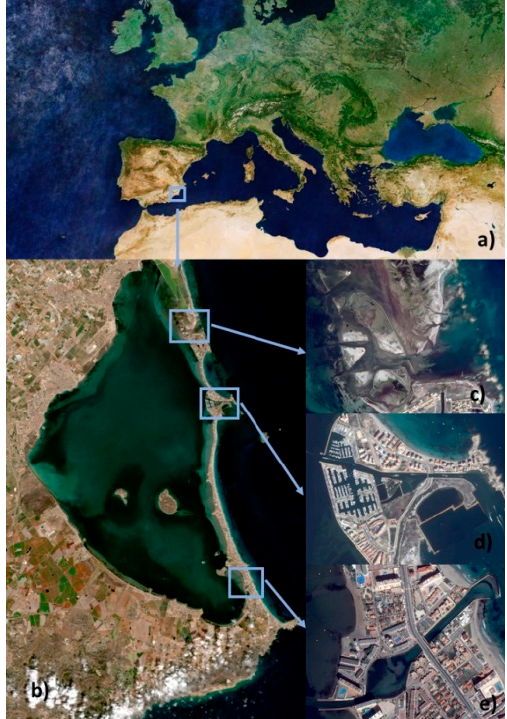
Figure 1. Study area in the Mar Menor lagoon. ( a ) Sentinel 3 image of the ESA, ( b ) Sentinel 2 image of the Mar Menor on 1 January 2019, and Pleiades 1A images on 28 November 2019 of the ( c ) Encañizadas, ( d ) Estacio, and ( e ) Marchamalo channels.